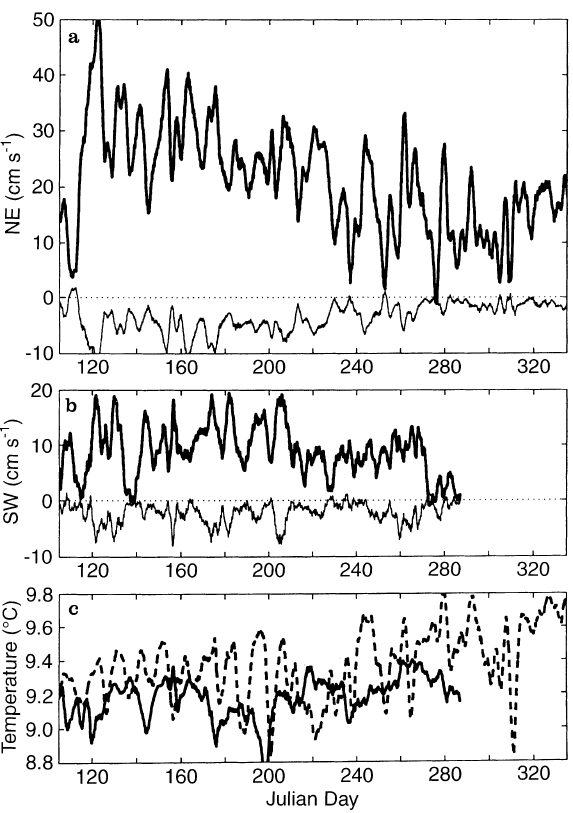
Fig. 6a–c. Time-series of (—–) along-slope and (- - -) across-slope velocity at a NE, b SW and c temperature at (—–) SW and (- - -) NE. Data have been filtered using a 50-h running